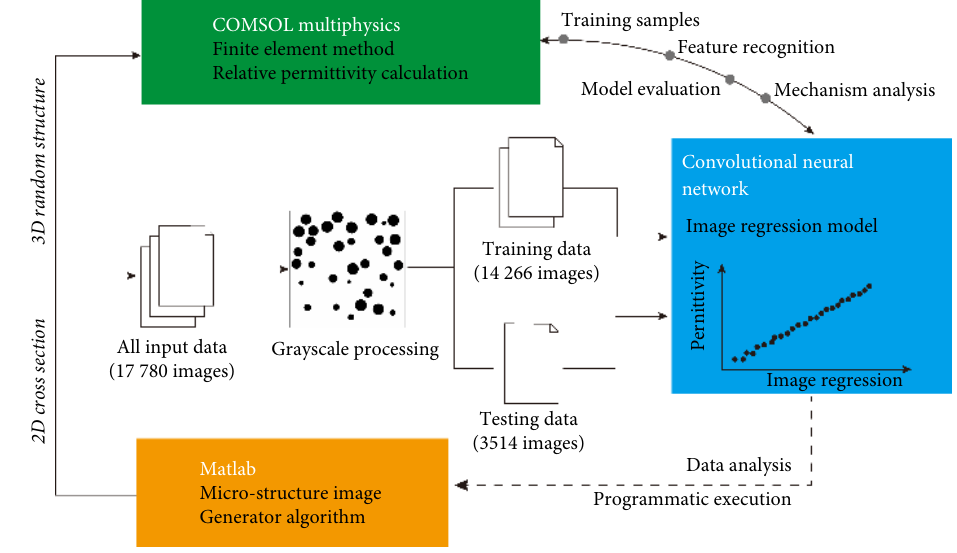
Fig. 1 Schematic of the workflow designed for prediction of the relative permittivity of BT/PVDF